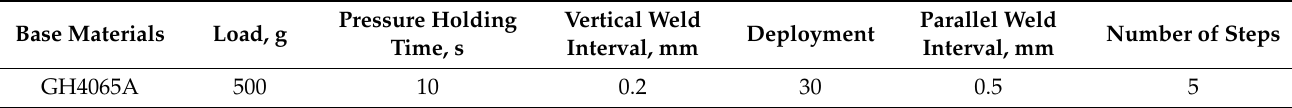
Table 3. GH4065A alloy microhardness test